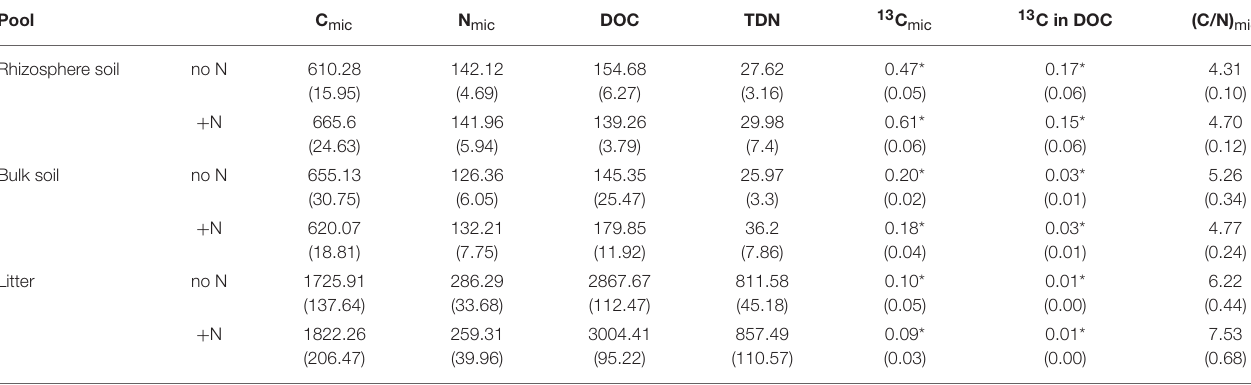
TABLE 2 | 13 C, C, and N in dissolved organic matter and microbial biomass. C mic , N mic , DOC, and TDN are means in µ g g − 1 dry weight, and 13 C mic and 13 C in DOC are atom% excess. Pool Rhizosphere soil